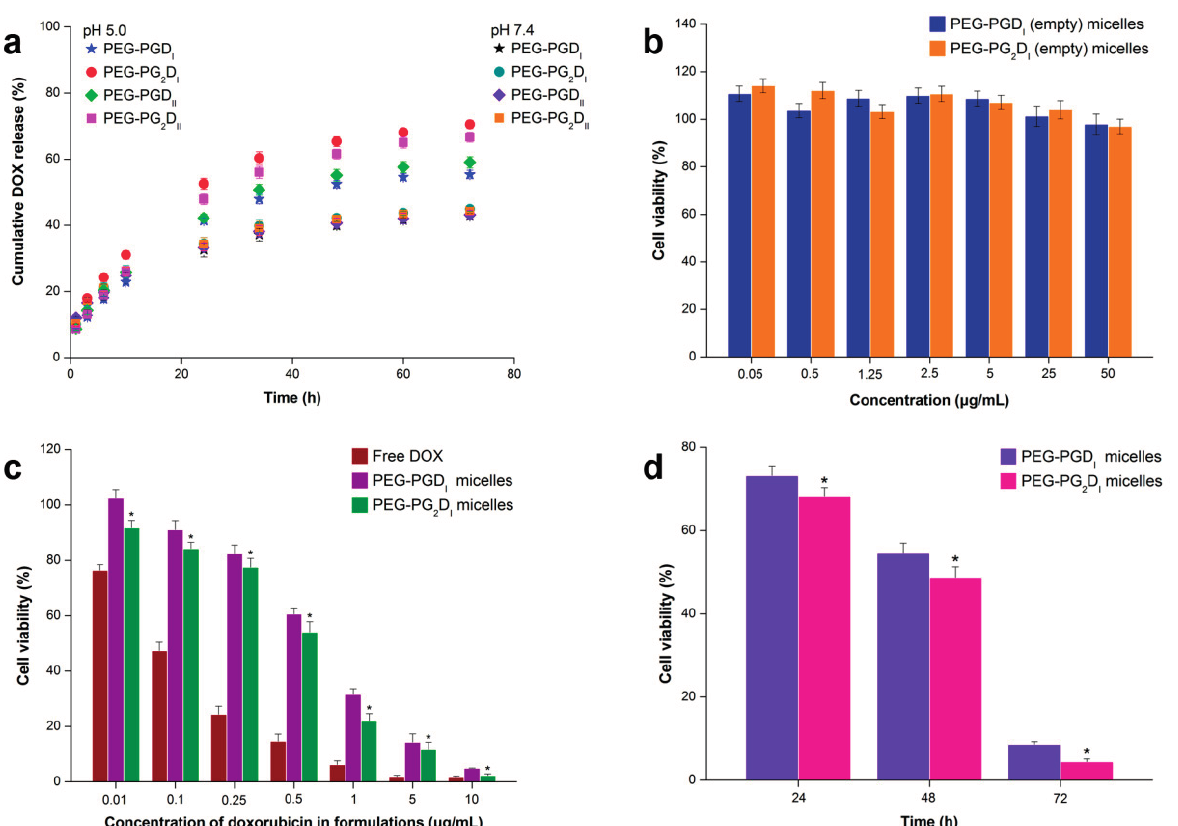
Figure 5. In vitro drug release and cytotoxicity assays. ( a ) In vitro DOX release profiles of the DOX-loaded polymer micelles at two different pH values (pH 5.0 and 7.4), Cytotoxicity of different concentrations of ( b ) empty polymer micelles and ( c ) Free DOX or DOX-loaded polymer micelles against HeLa cells by MTT assay, ( d ) Cytotoxicity of DOX-loaded polymer micelles against HeLa cells with different incubation times at the same drug concentration of 10 μ